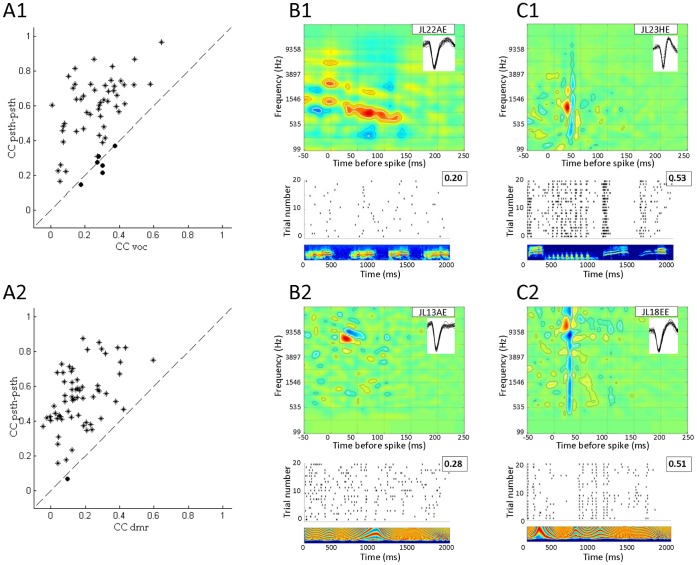
Inter-trial variability.A. Comparison between the inter-trial variability and the predictive power. The inter-trial variability computed with the Correlation Coefficient between PSTH (CCpsth-psth) is compared for each cell to the predictive power for the vocalizations (A1) and the DMR (A2). In most of the cases (black stars in A1 and A2), CCpsth-psth is significantly higher (paired t-test, p<.05) than CCvoc (A1) or CCdmr (A2). In very few cases (black dots), CCpsth-psth is not significantly different than CCvoc or CCdmr. B–C. Examples of four neurons showing either a low (B) or a high (C) spike timing reliability. For each plot, the neuron’s STRF (top) is shown, together with the raster plot (middle) of 20 responses to the stimulus for which the spectrogram (frequency vs. time) is represented on the bottom. Values inserted along the raster plots are the values of the trial-by-trial spike timing reliability as computed with the Rcorr. B1 and B2 show responses with a low spike-timing reliability, whereas C1 and C2 show responses with a high spike-timing reliability. Insets in each STRF show the AP waveforms. STRF units and scale are the same as in Figure 2.